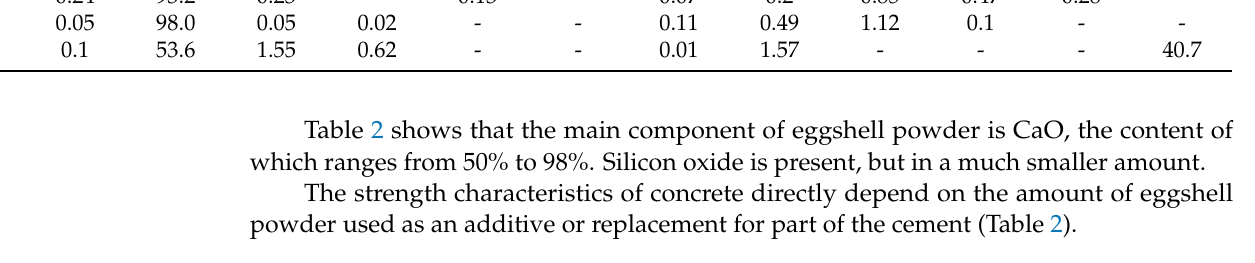
Table 2. The use of eggshell powder in concrete or mortar and its effect on the strength characteristics of finished